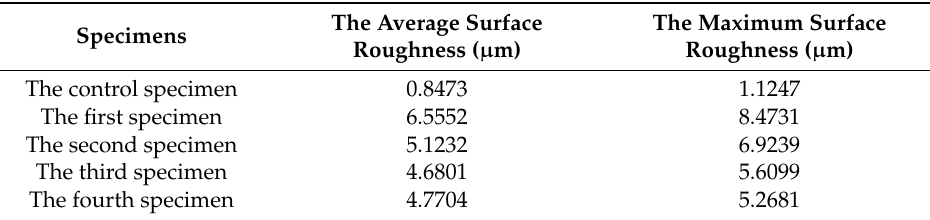
Table 4. The surface roughness of four